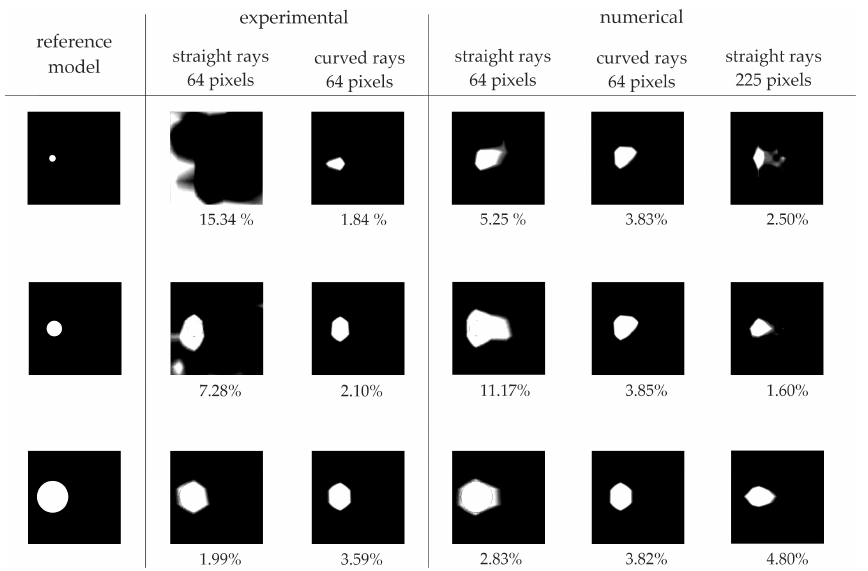
Figure 18. Error coefficient values for maps with reduced spectrum based on direct travel time measurement method.